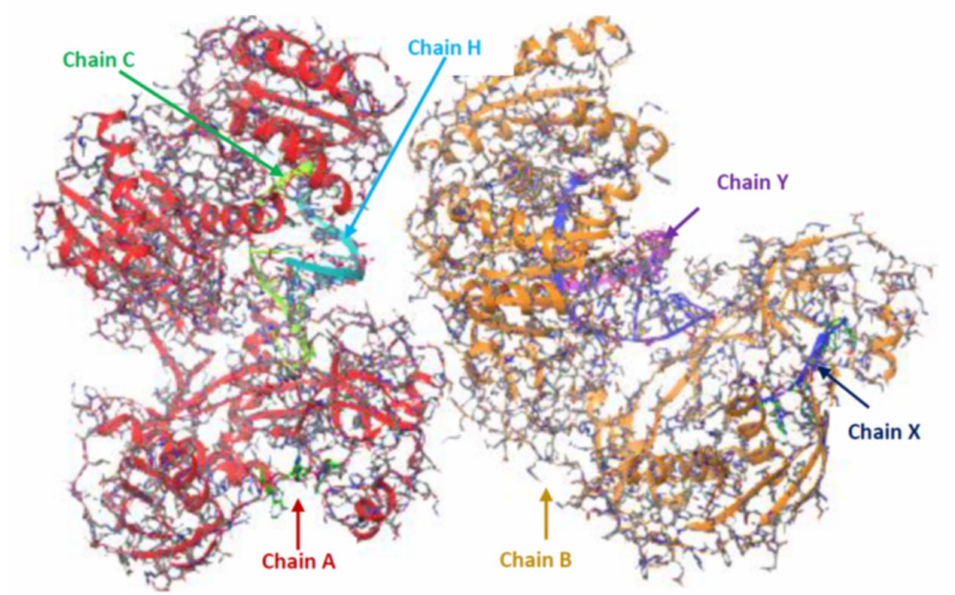
Figure 5. The receptor protein (3D-AGO protein) before preparation visualized by Maestro software.